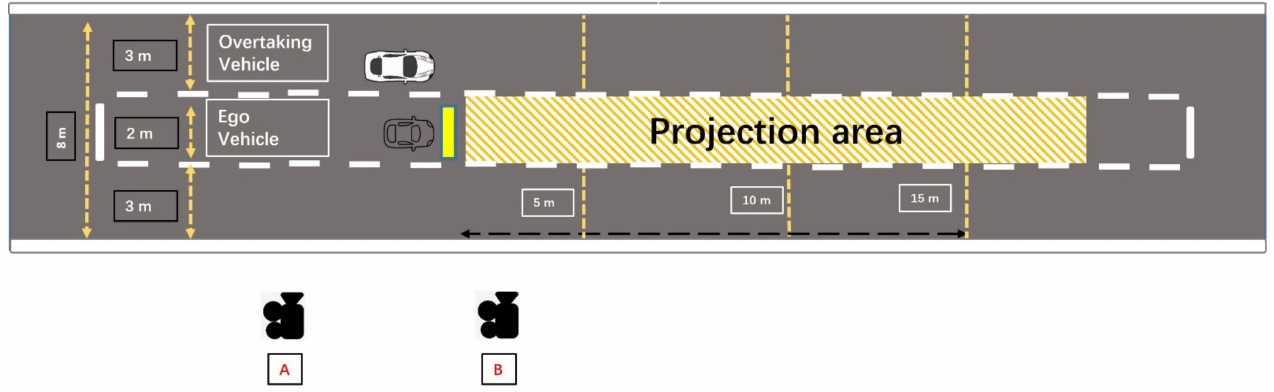
Figure 2. Experiment